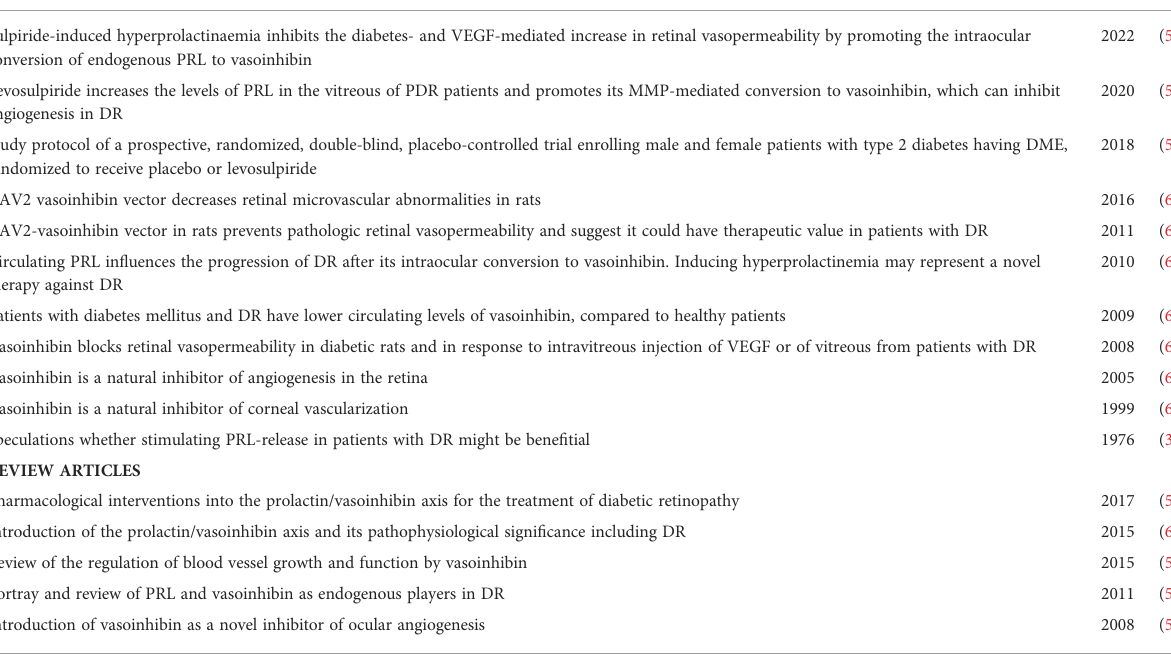
TABLE 1 Landmark original research articles and reviews highlighting the involvement of the prolactin/vasoinhibin axis in diabetic retinopathy. Brief